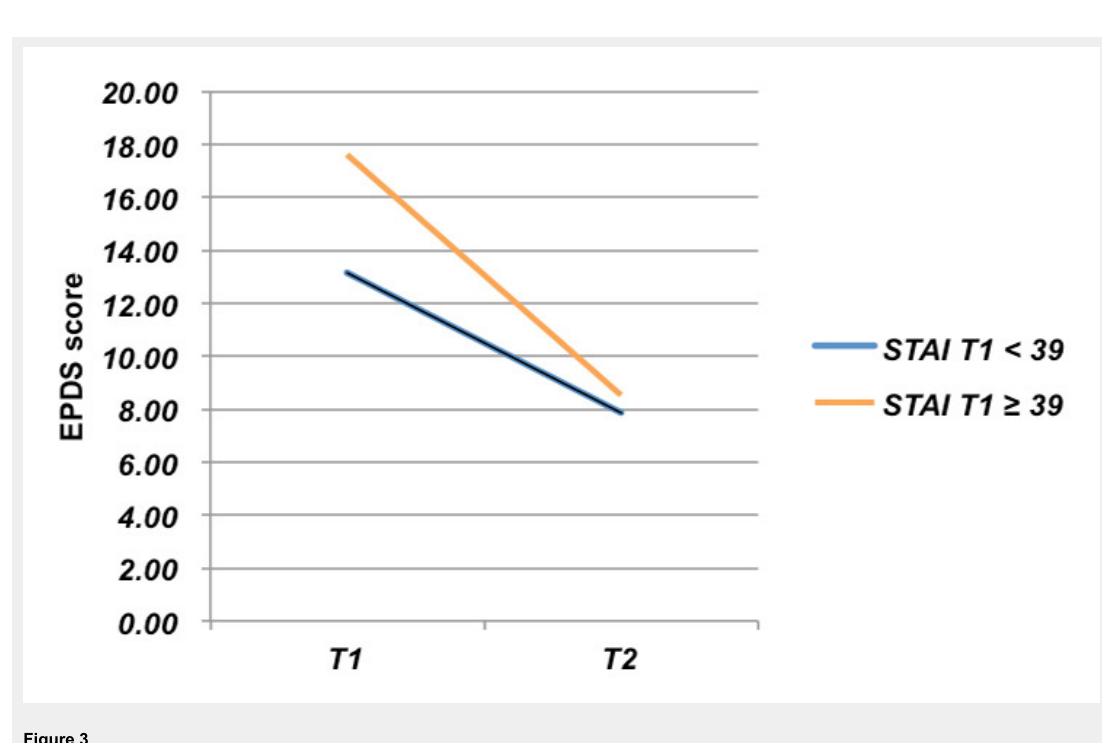
Figure 3 Change in depression depending on initial anxiety